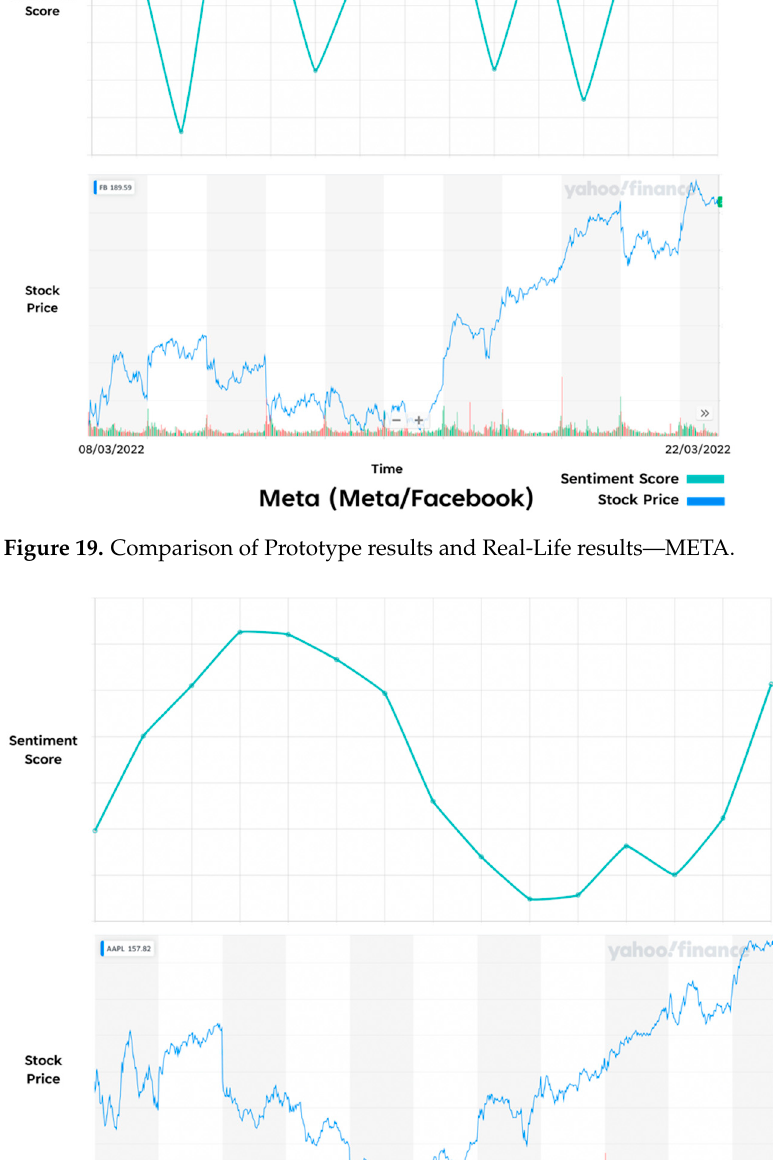
Figure 20. Comparison of Prototype results and Real-Life results—AAPL.